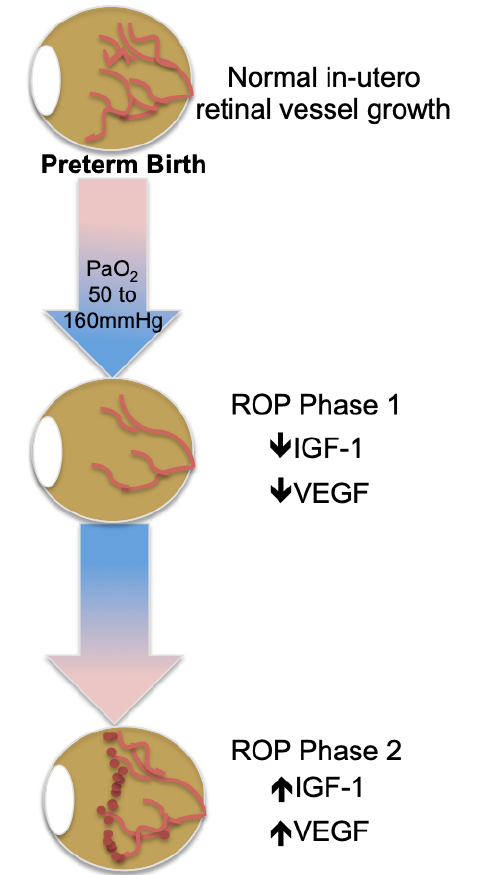
Figure 1. ROP molecular pathogenesis. ROP occurs in two phases following preterm birth and is mediated by a) oxygen; b) VEGF; and c)